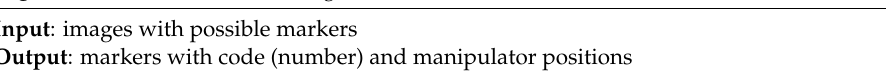
Algorithm 1. Marker detection algorithm.